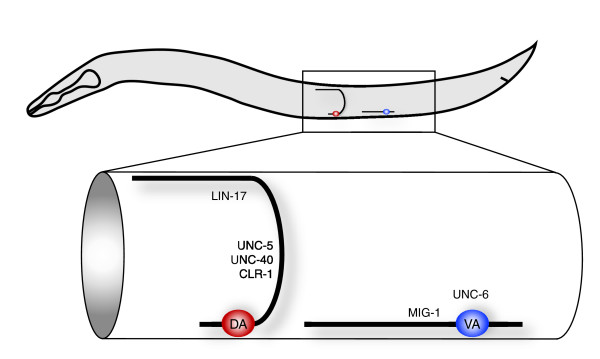
Differential expression of axon guidance cues and receptors in A-class motor neurons. Embryonic DA motor neurons extend commissures to innervate muscles on the dorsal side whereas larval VA motor axons are retained in the ventral nerve cord. DA axons are steered dorsally by interaction of the repulsive cue UNC-6 (netrin) with receptors, UNC-40 (DCC) and UNC-5, and the CLR-1 receptor tyrosine phosphatase [90,91]. VAs do not express these receptors and project ventrally directed axons. Enrichment of the Wnt receptors lin-17 in the embryonic A-class motor neuron dataset and mig-1 in the larval A-class motor neuron profile could be indicative of a Wnt-dependent mechanism for directing anterior outgrowth of DA and VA motor axons.